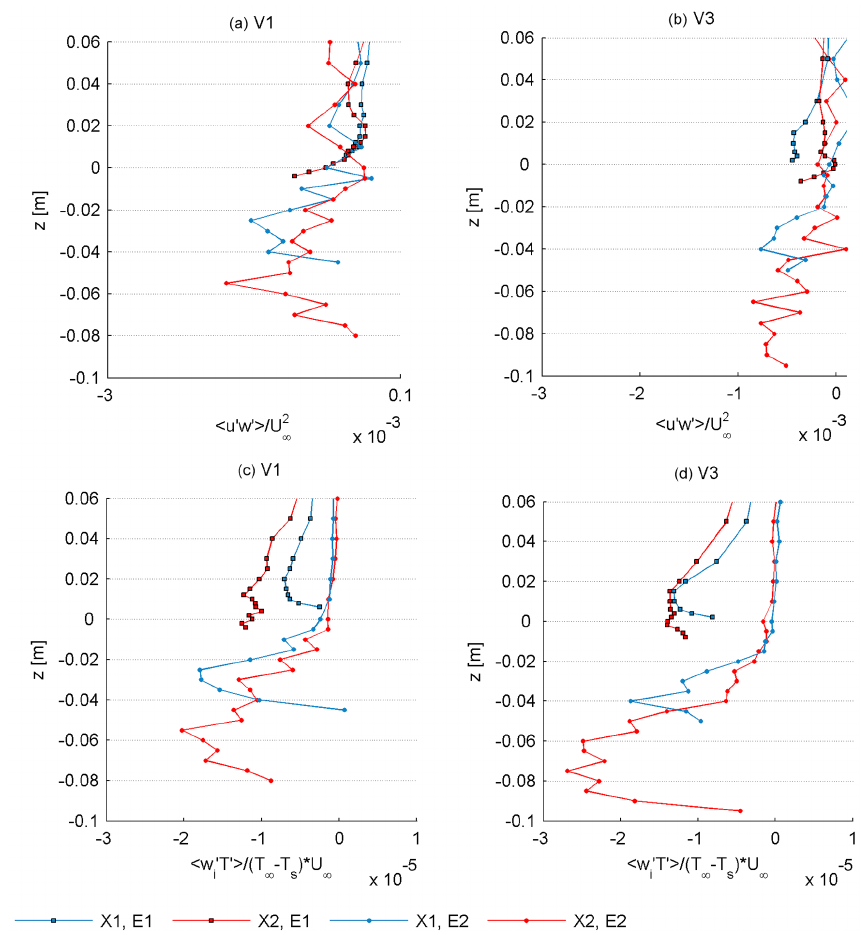
Figure 4. Vertical profiles of the turbulent fluxes: momentum flux u (cid:48) w (cid:48) (a, b) and vertical heat flux w (cid:48) T (cid:48) (c, d) normalized by the temperature difference and free-stream wind